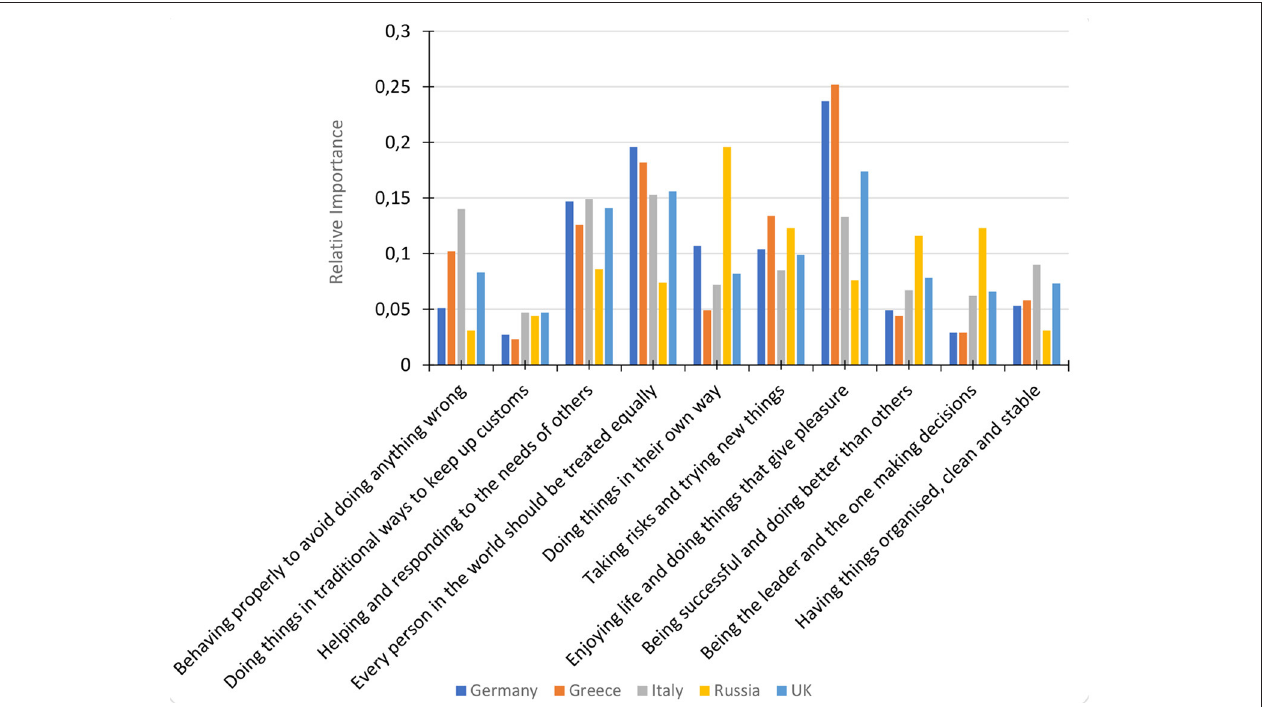
FIGURE 1 | MaxDiff relative importance of general values by participant nationality.